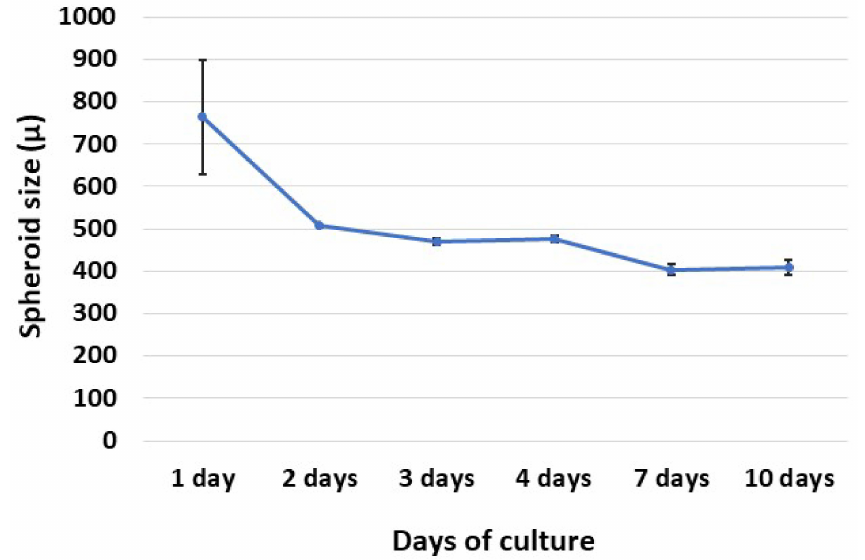
Figure 3. Line chart showing the size of the spheroids ( µ ) throughout 10 days of culture in basal conditions. The data are presented as mean values ± SEM (n =